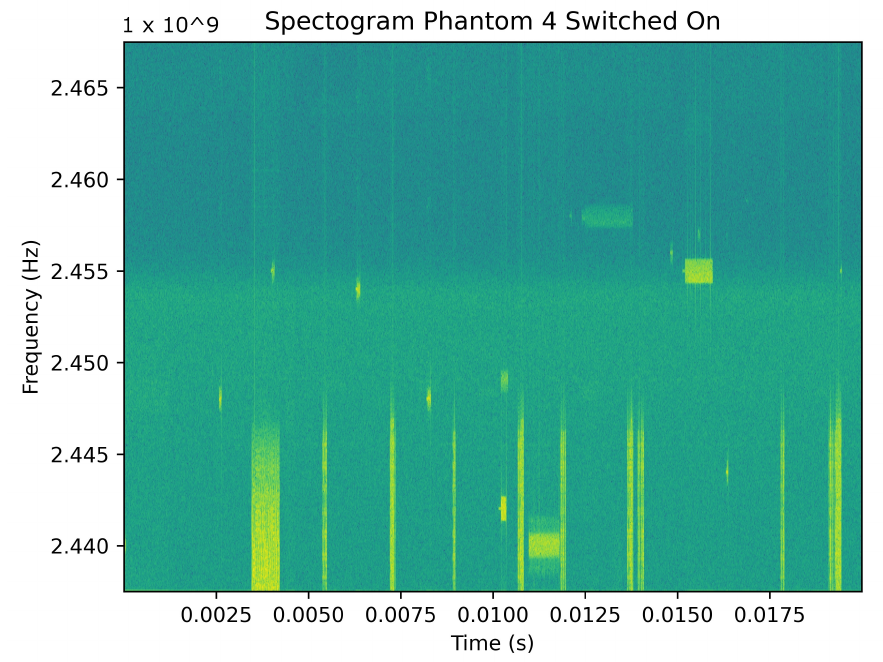
Figure 4. Spectrogram: Phantom 4 switched